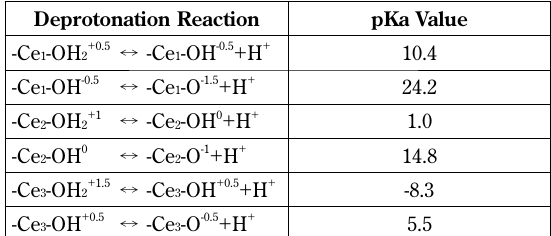
Table 2 Equilibrium constants for deprotonation reactions for aqueous dispersions of ceria particles [24]] Deprotonation